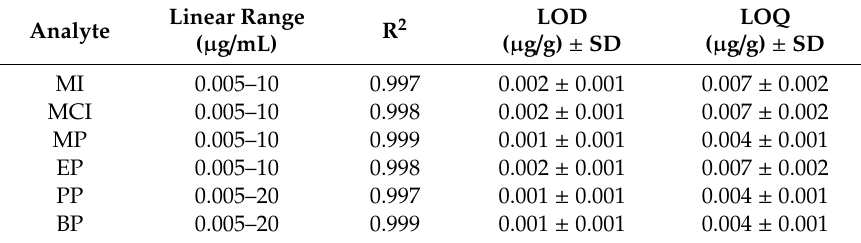
Figure 2. UHPLC / DAD chromatograms of methylisothiazolinone (MI), methylchloroisothiazolinone (MCI), methylparaben (MP), ethylparaben (EP), propylparaben (PP) and butylparaben (BP) obtained at different absorbances, ranging from 250 to 280 nm. The best separation was achieved at absorbance 255 nm. Table 1. Results of linearity (R 2 ), limits of detection (LOD) and limits of quantification (LOQ).